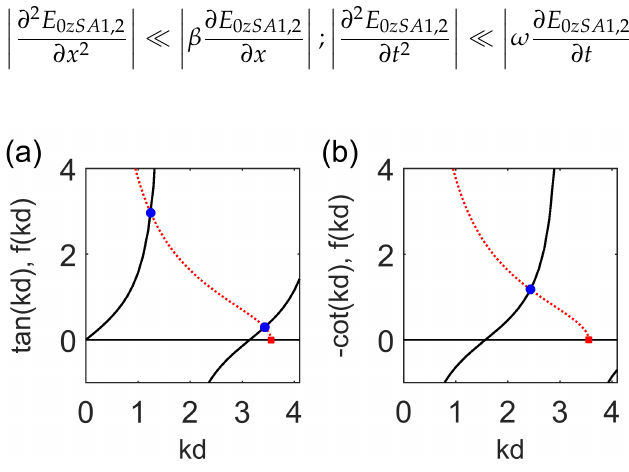
Figure 2. Graphic solution of the disperison relations for the TM even modes ( a ) and odd modes ( b ); (cid:114) (cid:16) (cid:17) 2 V − ε (cid:107) f ( kd ) = ε ⊥ , ω = 5 π × 10 14 s − 1 . ε r 2 ε ⊥ kd